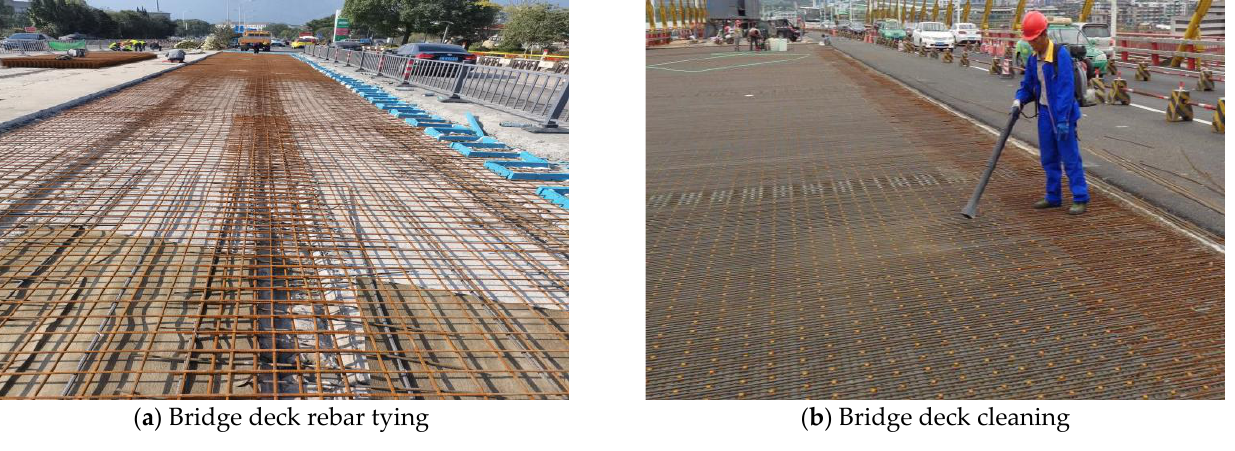
Figure 6. Preparation before UHPC construction.